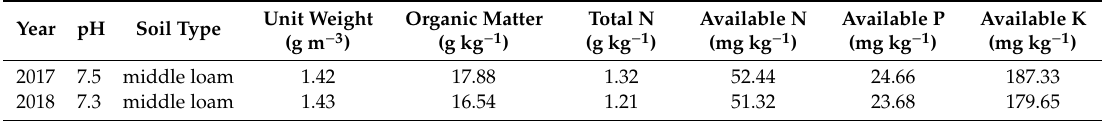
Figure 2. Distribution of precipitation and air temperature in 2017 and 2018 during the experiments. Note : Figure ( a ) showed the precipitation and air temperature in 2017, and figure ( b ) showed the precipitation and air temperature in 2018 Table 1. Soil properties used in the pot experiments .